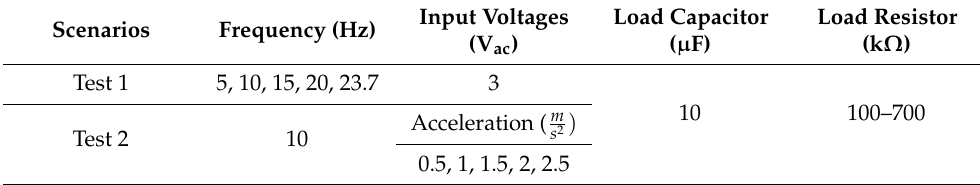
Figure 11. Experimental circuit diagram and experimental setup.